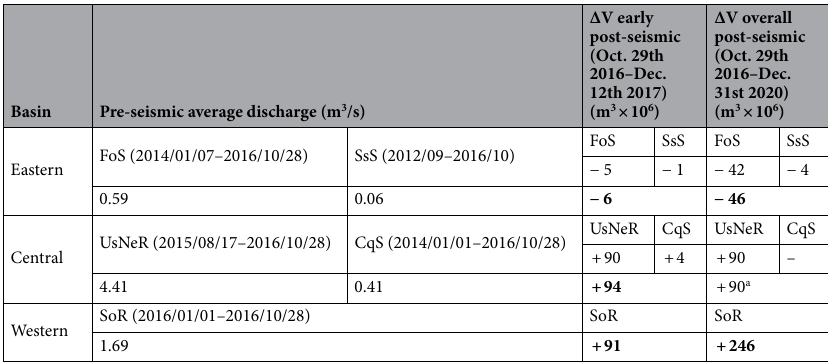
Table 2. Variations of groundwater volume (ΔV) released by the main local and streambed springs in early and overall post-seismic reference periods. Volumes are measured in million cubic meters (m 3 × 10 6 ) to make them immediately comparable wit each other. Spring acronyms refer to Table 1 and to Fig. 1 Values in bold represent the overall variations of groundwater volume realesed by each Basin in the early and in the overall post-seismic periods. a Underestimated value not inclusive of the CqS